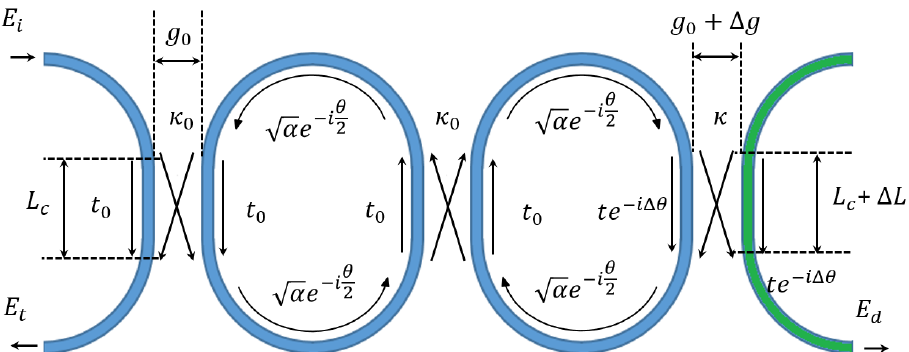
Figure 7. The parametric model of the accelerometer. α denotes the loss coefficient of the waveguide (when α = 1, lossless). θ denotes the phase change of the waveguide mode after a round trip transmission of a ring resonator θ = θ L + 2 θ 0 , where θ L represents the phase shift after a round trip length without coupling, and θ 0 represents the phase shift difference between bus waveguide and directional coupler. E i , E t , and E d denote the electrical field at the input, through and drop port of the circuitry.